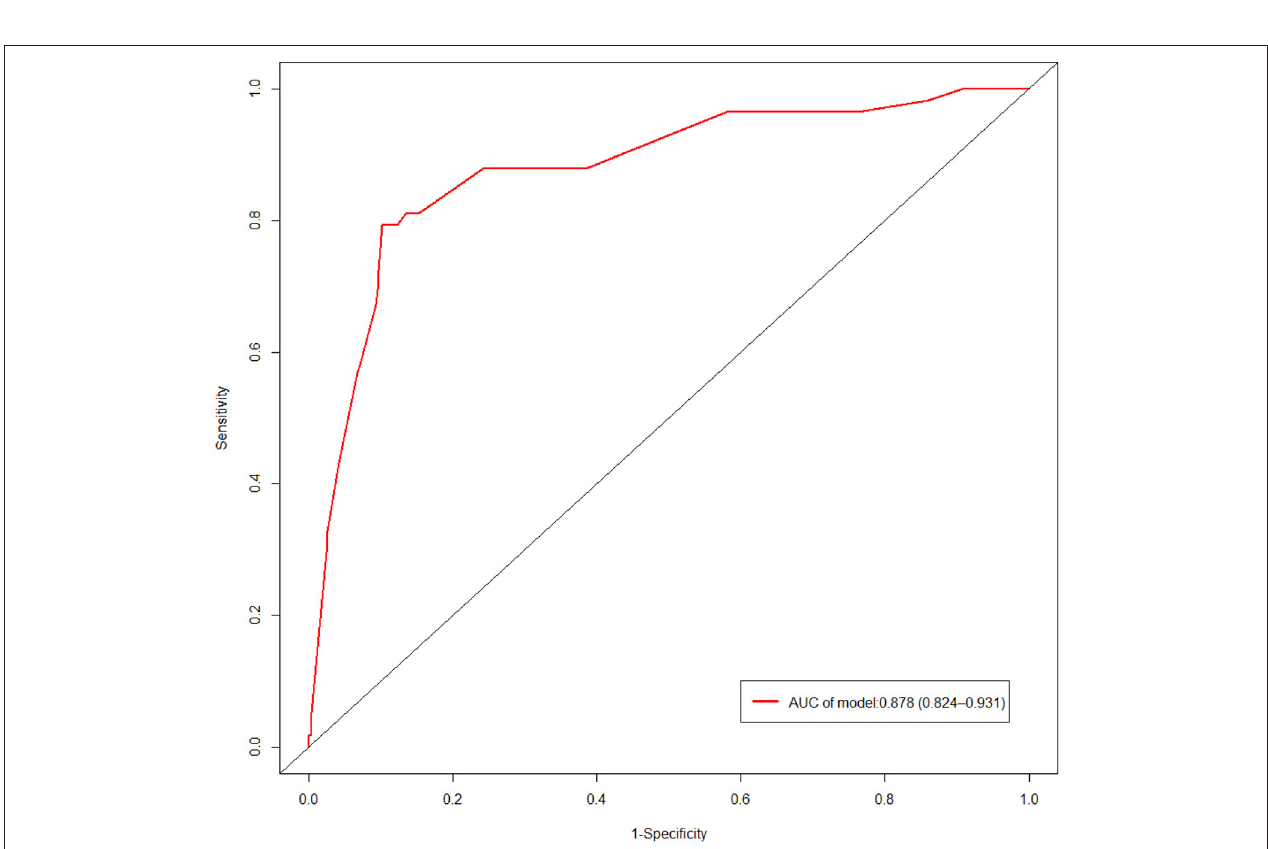
FIGURE 3 | Receiver operating characteristic curve of the prediction model. AUC, Area Under Curve.